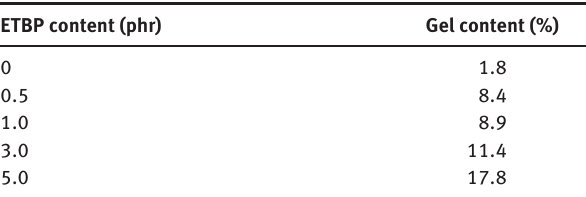
Table 2: Gel content of the PLA/PBAT blends with different content of ETBP.